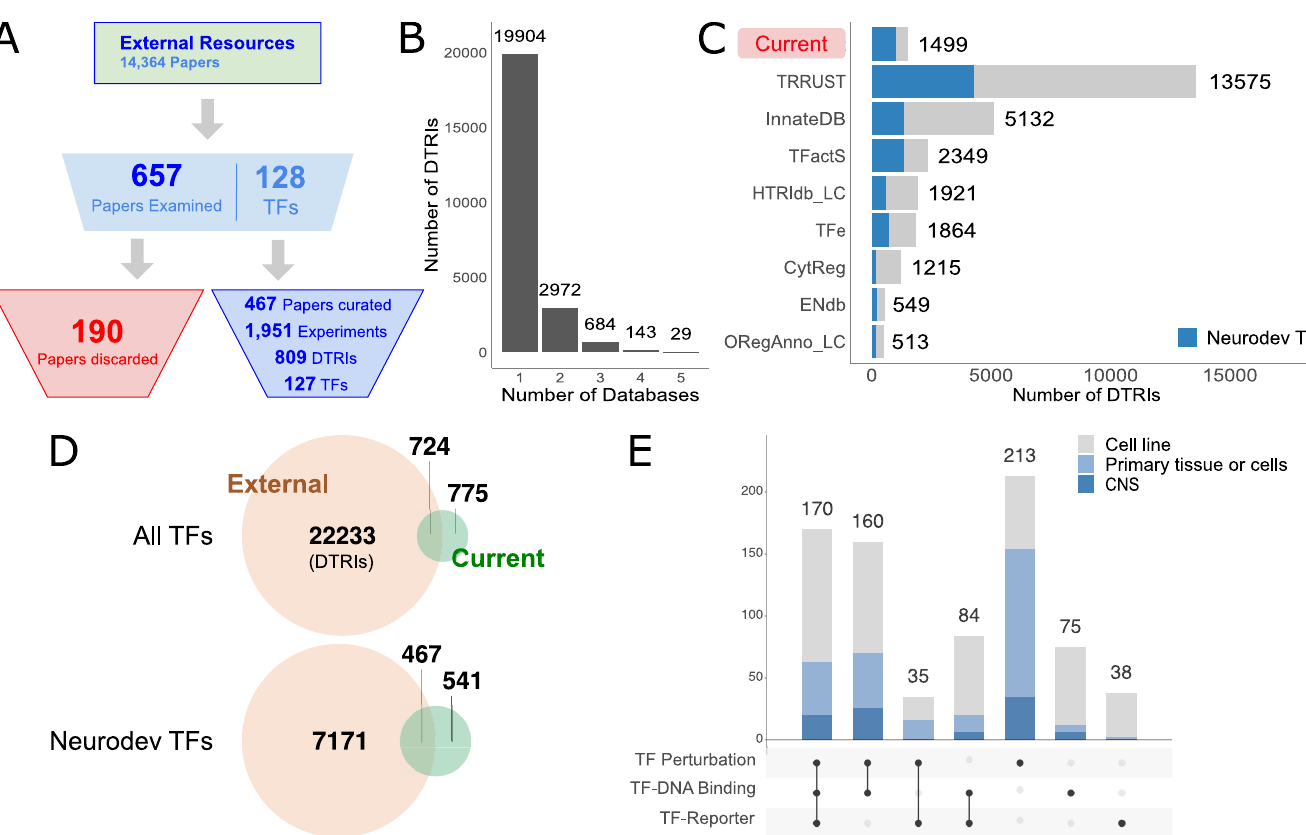
Fig 4. Comparison with external resources. (A) Flow chart of candidate papers obtained from seven external resources. (B) Distribution of DTRIs across the number of resources. Most DTRIs are only recorded in a single database whereas 29 DTRIs are recorded in five databases. No DTRIs have been recorded by more than five databases. (C) Number of DTRIs in each database. DTRIs involving neurodevelopmental TF regulators are highlighted in blue. (D) Venn diagrams showing the overlap between DTRIs recorded in previous curation databases versus the current study, broken down by all TFs (top) and those associated with neurodevelopmental TFs (bottom). (E) Breakdown of DTRIs unique to our curation across different combinations of experiment types. Colors correspond to cellular contexts indicated in the color legend.